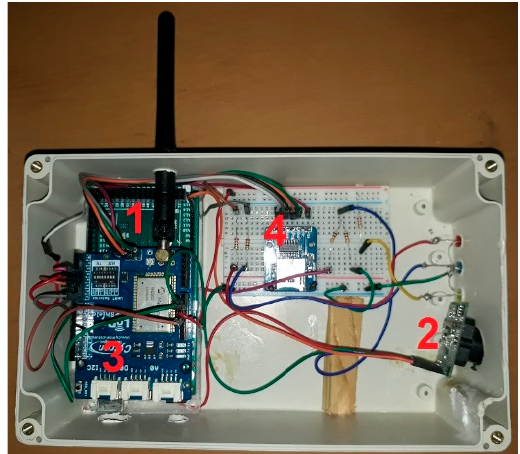
Figure 5. Components of the LoRa transmission node: ( 1 ) Arduino Mega microprocessor. ( 2 ) TTL Serial JPEG camera. ( 3 ) LoRa Shield radio adapter. ( 4 ) SD Card Module.